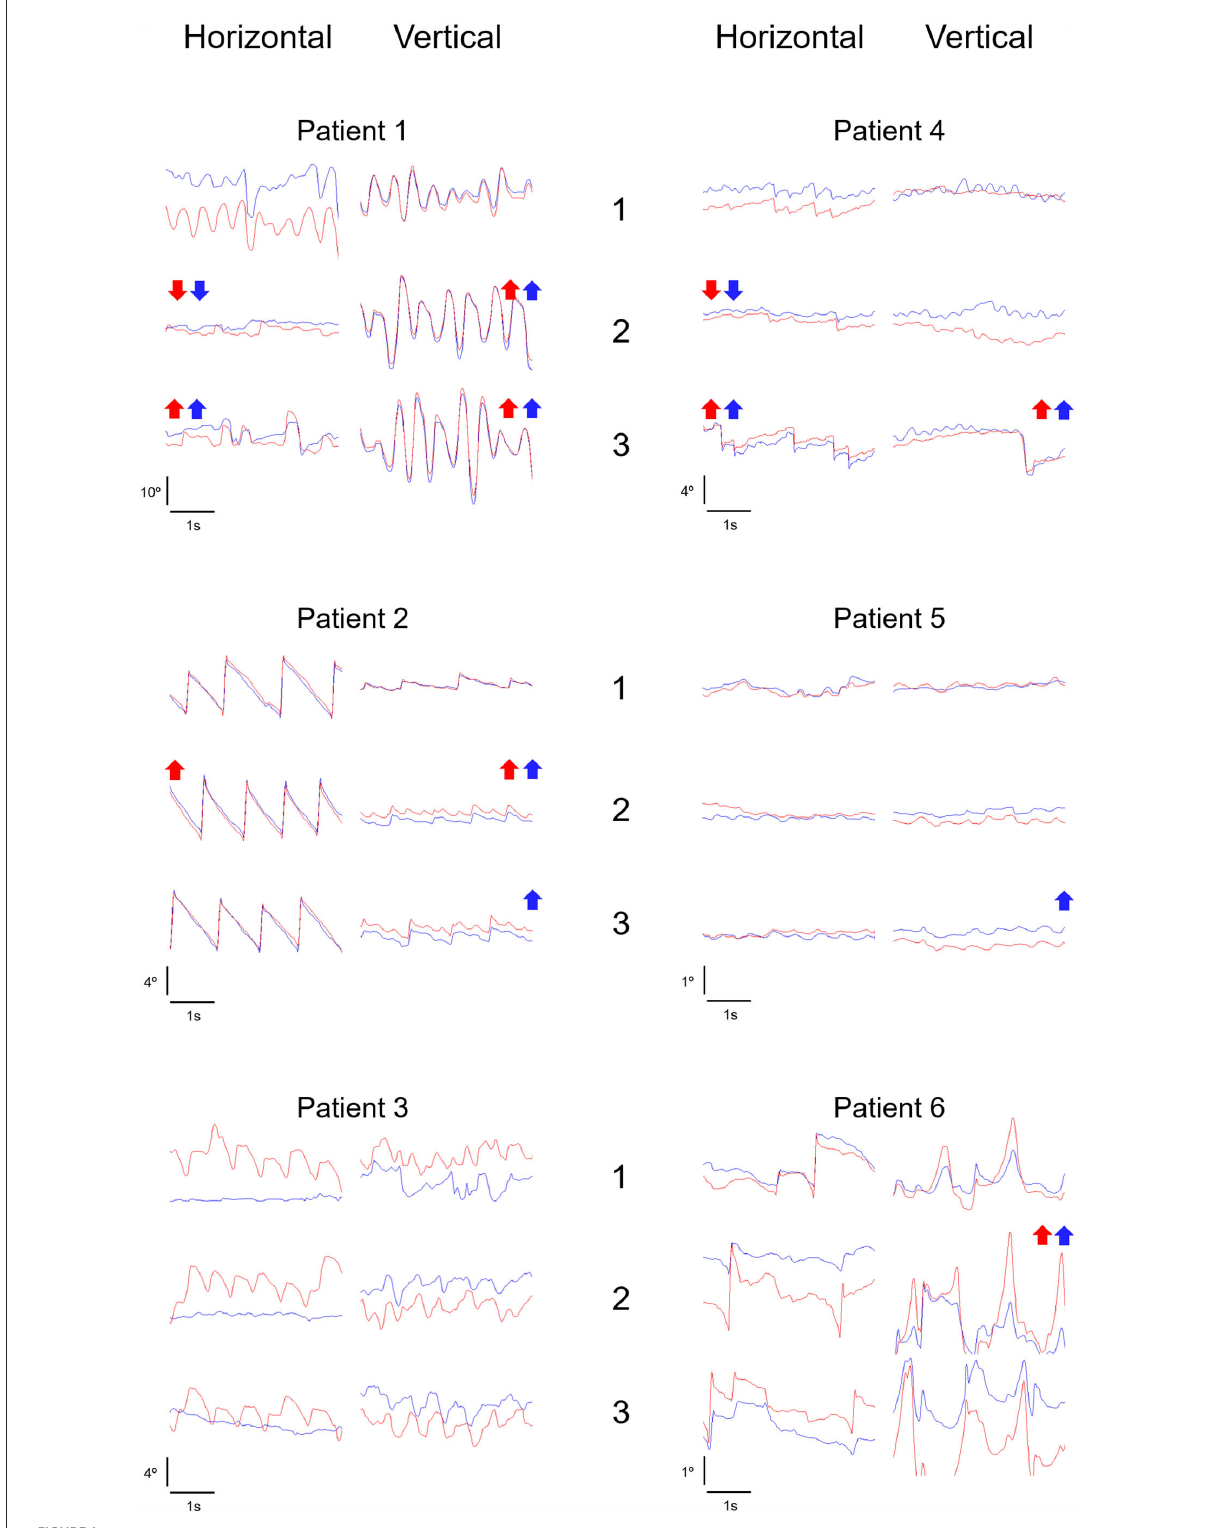
FIGURE1 Ocular motor data. Nystagmus horizontal and vertical representative tracings in visits 1, 2, and 3 are depicted for each patient. Arrows up represent a > 50% increase (i.e., worsening) in amplitude and/or velocity of nystagmus (red arrow, right eye; blue arrow, left eye), relative to the previous visit. Arrows down represent a > 50% decrease (i.e., improvement) in amplitude and/or velocity of nystagmus (red arrow, right eye; blue arrow, left eye), relative to the previous visit. Red tracing, right eye. Blue tracing, left